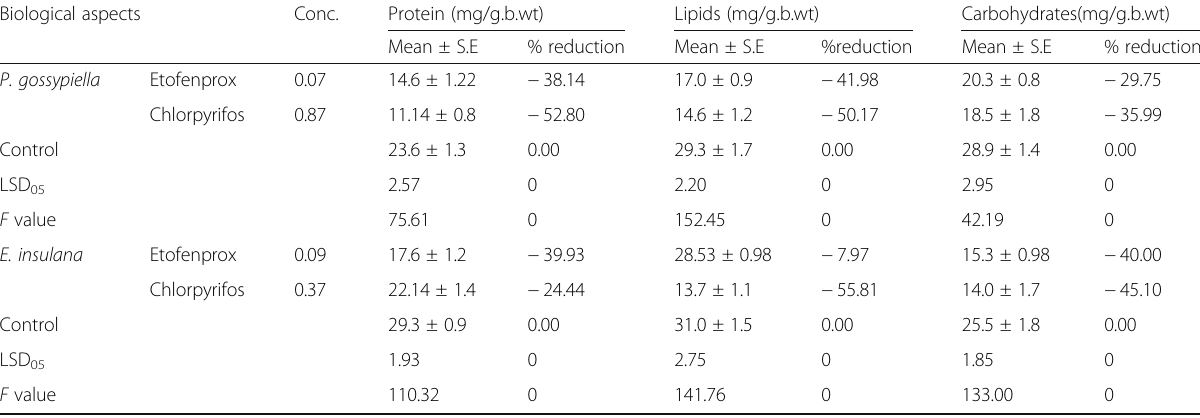
Table 4 Effect of tested compounds on physiological of two hosts, full-grown P. gossypiella and E. insulana (resulted from treated newly hatched larvae) Biological